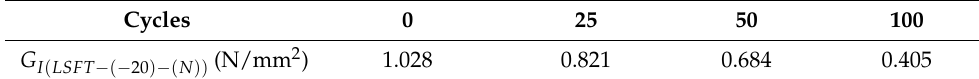
Table 7. Linear superposition fracture energy calculation.